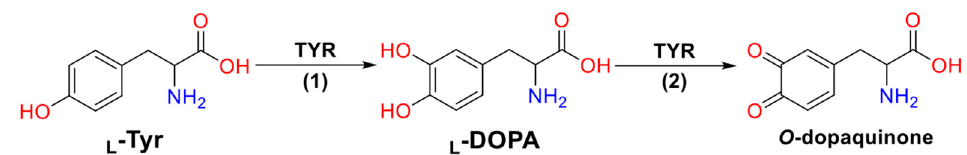
Figure 1. Reactions catalyzed by the TYR enzyme in melanogenesis.